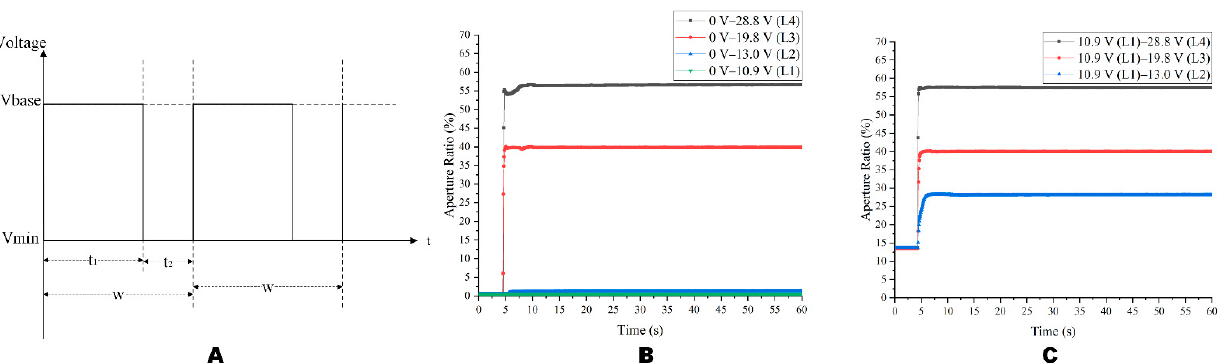
Figure 14. A change in switching between four gray scale levels driven by a square wave. ( A ) The square wave driving waveform experiment diagram. ( B ) The curve of the aperture ratio when 𝑉 (cid:3029)(cid:3028)(cid:3046)(cid:3032) changed from 0 V to L1~L4. ( C ) The curve of the aperture ratio when 𝑉 (cid:3029)(cid:3028)(cid:3046)(cid:3032) changed from L1 to L2~L4. ( D ) The curve of the aperture ratio when 𝑉 (cid:3029)(cid:3028)(cid:3046)(cid:3032) changed from L2 to L1, L3, and L4. ( E ) The curve of the aperture ratio when 𝑉 (cid:3029)(cid:3028)(cid:3046)(cid:3032) changed from L3 to L1, L2, and L4. ( F ) The curve of the aperture ratio when 𝑉 (cid:3029)(cid:3028)(cid:3046)(cid:3032) changed from L4 to L1~L3. Based on the stable driving phase, the overdriving pulse was added, and the driving waveform is shown in Figure 15A. The relevant parameters were 𝑤 = 23.26 ms ( 𝑓 = 43 Hz), 𝑡 (cid:2870) = 4.88 ms, 𝑡 (cid:2871) = 3.72 ms, 𝑉 (cid:3040)(cid:3028)(cid:3051) = 28.8 V and 𝑀 = 6. As shown in Figure 15B, dif- ferent from the square wave, the driving waveform proposed in this paper successfully made the EWD generate four gray scales from the 0 V. As could be seen from Figure 14D,E and Figure 15D,E, proposed waveforms have good aperture ratio consistency and a faster response time. From L2 to L1, the proposed waveform was 14.57 s faster than the square wave, and the gray scales could be stabilized faster. As could be seen from Figures 6 and 15B, the driving waveform proposed in this paper could make the aperture ratio with 13 V driving reach 11.31%, which was 3.7 times that of the DC driving. When the driving voltage was 13 V, the aperture ratio of the driving waveform proposed in this paper reached 11.31%, which was 3.7 times that of the DC driving.